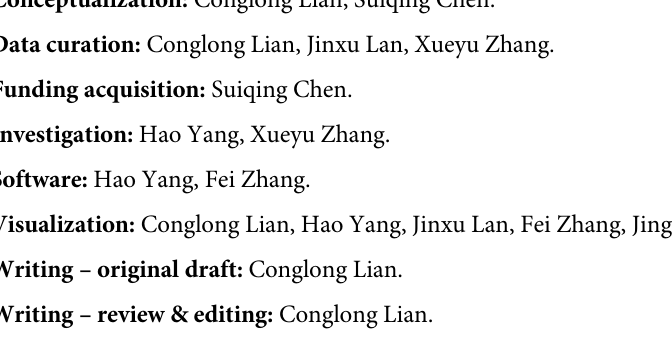
S1 Fig. Sequence alignment of chloroplast genomes from three accessions of I . rubescens by mVISTA. Gray arrows above the alignment indicate the position and direction of transcrip- tion of each gene. The scale on the vertical axis shows the percent sequence identity between 50% and 100%. IR-J , IR-X , and IR-L are the three accessions of I . rubescens . (TIF) S1 Table. Raw data quality information for the I . rubescens chloroplast genome. (DOCX) S2 Table. Base composition of the I . rubescens chloroplast genome. (DOCX) S3 Table. The intron and exon analysis of intron-containing genes in the chloroplast genome of I . rubescens . S4 Table. Summary of the features of five chloroplast genomes from three species of Iso- don . S5 Table. SNPs and indels present in the I . rubescens chloroplast genomes. IR-J , IR-X , and IR-L are the three accessions of I . rubescens